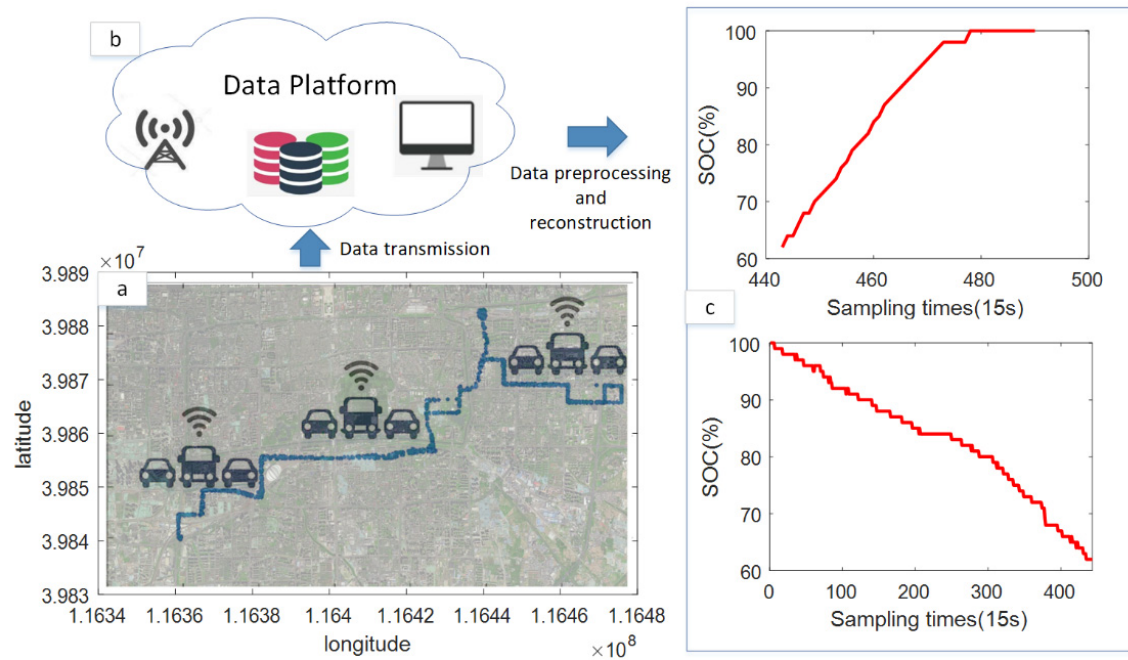
Figure 1. Electric bus operation data transmission and preprocessing results. ( a ) Driving route, ( b ) electric vehicle big data cloud platform and ( c ) preprocessing results of battery SOC.